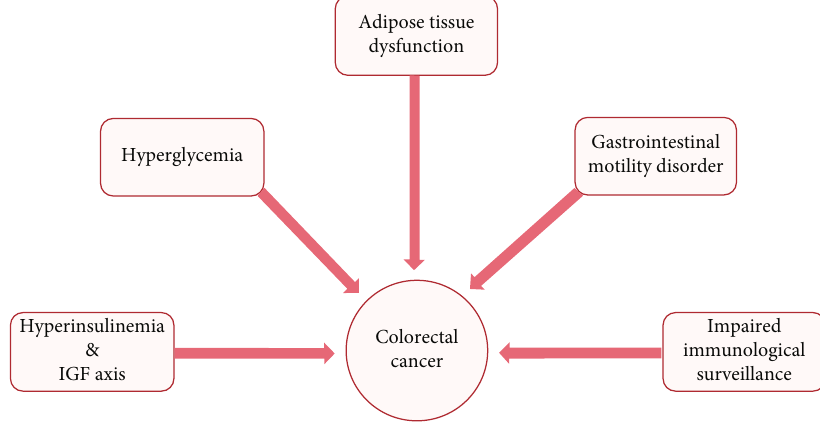
Figure 5: Predisposing factors of patients with T2DM for